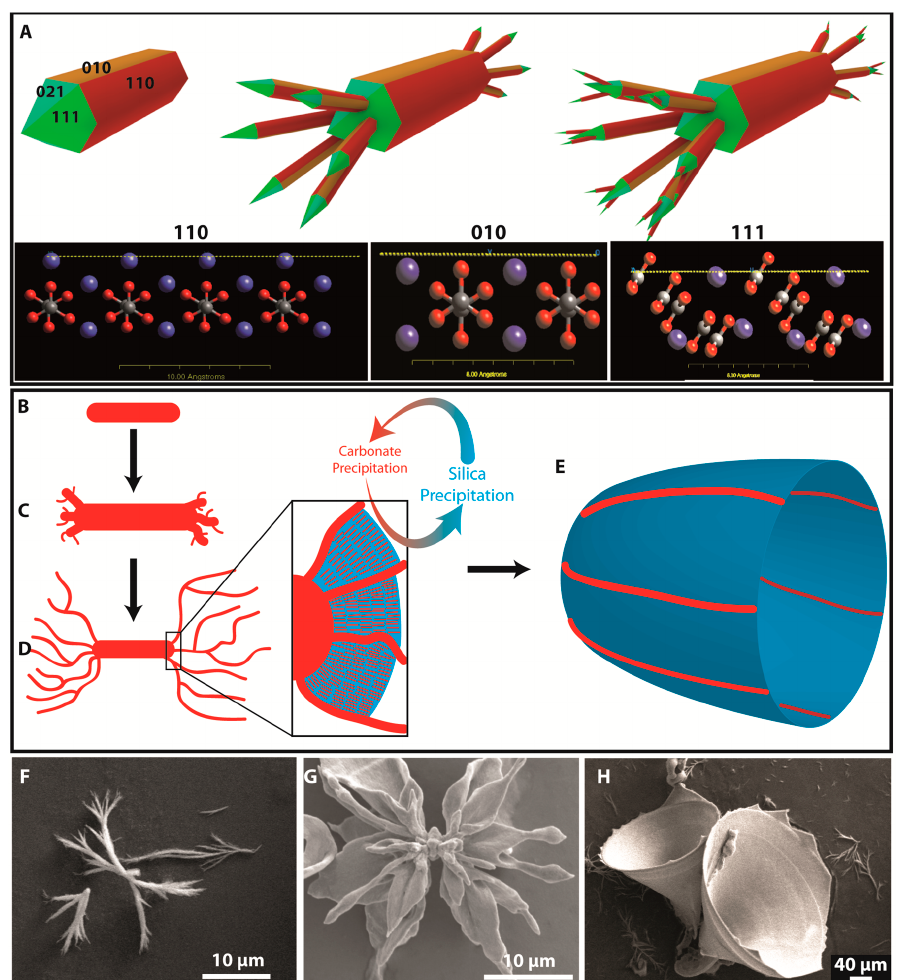
Figure 3. Formation of trumpet-like morphologies at 45 °C and 5 mM BaCl 2 . ( A ) Scheme of a primary witherite crystal (top), which successively becomes branched due to specific interactions of silica with different faces of the carbonate crystal. Vacuum surface cuts of these faces (bottom) indicate that the (110) faces are positively charged and thus prone to be blocked by negatively charged silicate species. Also, (010) is polar and therefore also likely to interact with negative silica species. Further growth thus occurs through the neutral (021) and (111) faces, so that up to six branches can emerge from the pseudo-hexagonal base. Repetition of this process leads to multiple branching generations. ( B – E ) Schematic overview of the growth process of a trumpet-like structure: an initial elongated BaCO 3 twin crystal seed grows and undergoes fractal branching as described in (A). At high temperature, this leads to open architectures with large branches, between which polycrystalline growth (i.e., autocatalytic co-precipitation of silica/witherite nanoparticles) occurs and slowly fills up the empty space (inset). Depending on the orientation of the branching, trumpet-like aggregates are formed. ( F– H ) SEM micrographs of the initial stage of open fractal branching ( F ), followed by filling of the branches with biomorphic composite material ( G ), ultimately leading to trumpet-like forms ( H ).